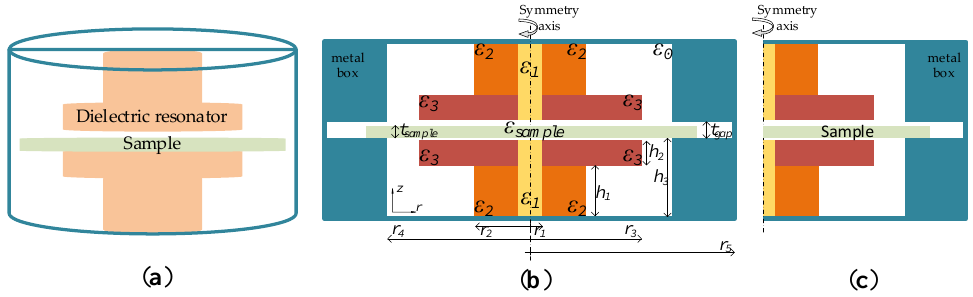
Figure 1. Visualization of the considered SPDR: ( a ) in 3D; ( b ) materials used and geometry with details; ( c ) 2D representation using axial symmetry.